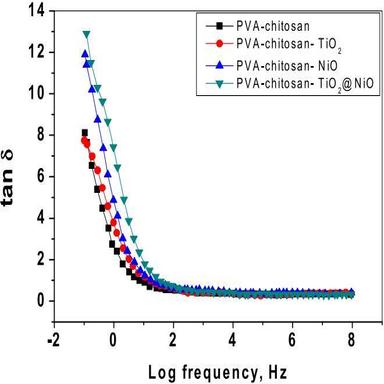
Variations in the dielectric loss tangents of PVA-chitosan–TiO2, PVAchitosan–NiO, and PVA-chitosan– TiO2@ NiO films.